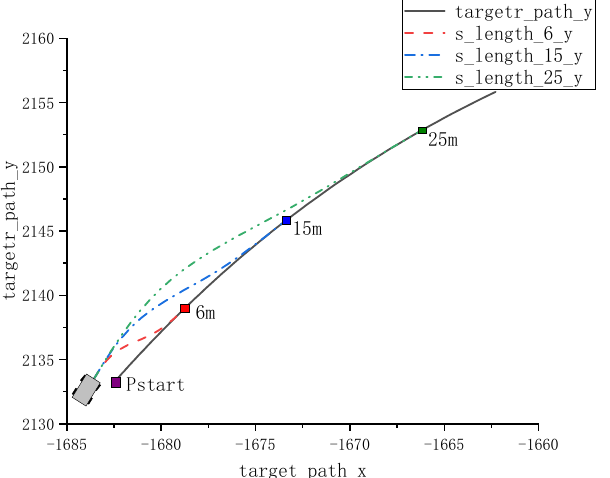
Figure 4. Influence of the selection of preview point on the calculation deviation of control path. The point closest to the predicted vehicle position on the reference path is selected as the first point on the preview point interval. The last point on the preview point interval is calculated from the speed and the bending degree of the target curve. The specific de termination method is shown in Table 2. Table 2. The overall algorithm flow